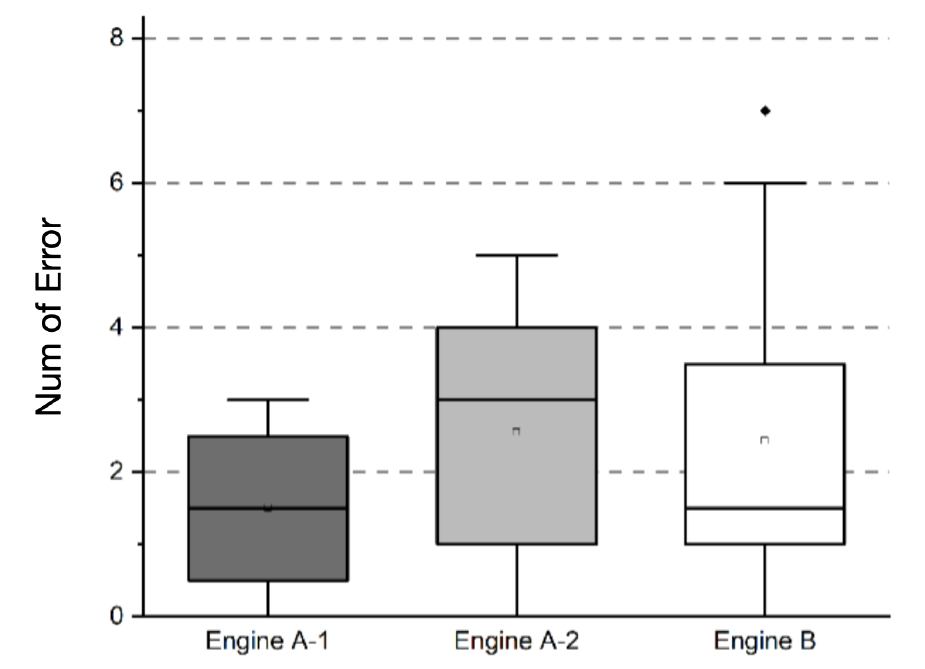
Figure 36. Mean number of errors during the implementation in engine maintenance